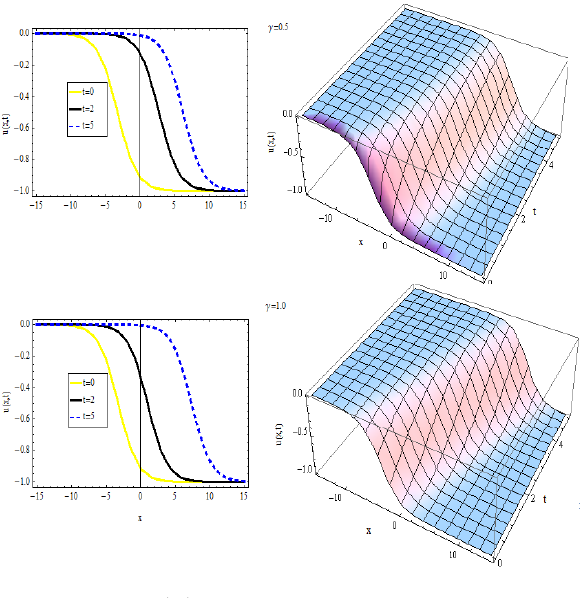
Figure 2: Graphs of (12) for conformable time-fractional Cahn-Allen equation.